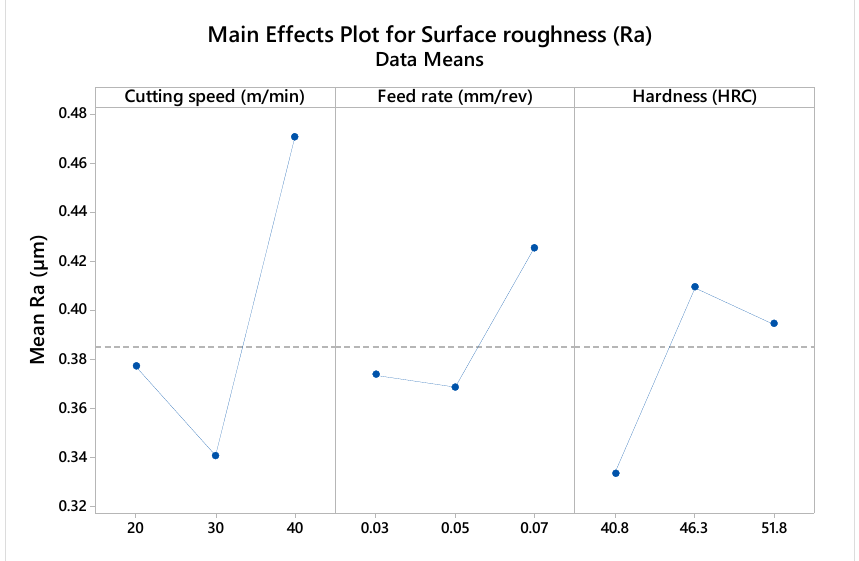
Figure 11. Main effect plot of Ra ( μ m) to cutting parameters. Figure 11. Main e ff ect plot of Ra ( µ m) to cutting